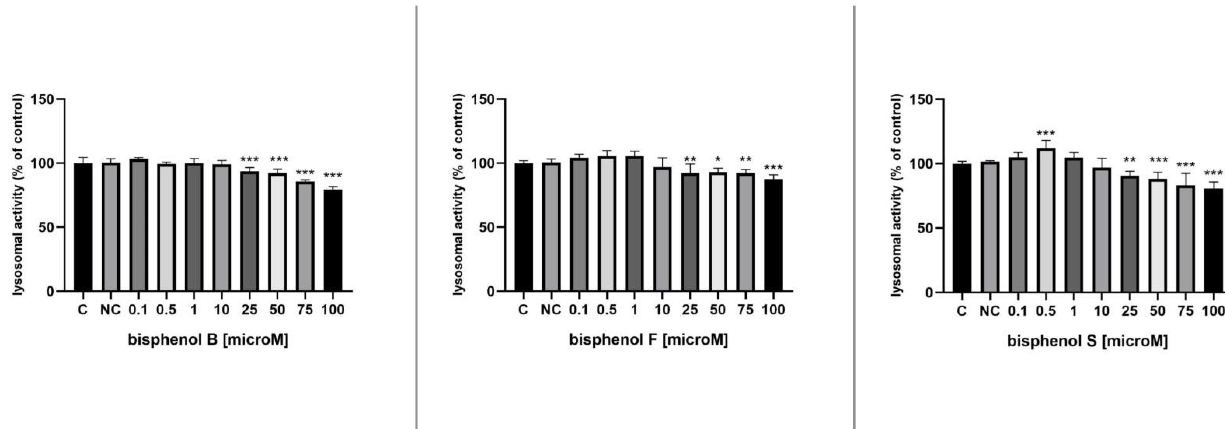
Figure 4. The impact of bisphenol B, F, and S on H295R cells lysosomal activity in vitro. Abbreviations: C — control group, NC — negative control. The mean (±SEM) optical density percent of the control (untreated) and treated (bisphenol) groups is represented by each bar. The data were collected from three separate experiments. Between the control and experimental groups, the significance levels were established at *** ( p < 0.001), ** ( p < 0.01), and * ( p < 0.05).